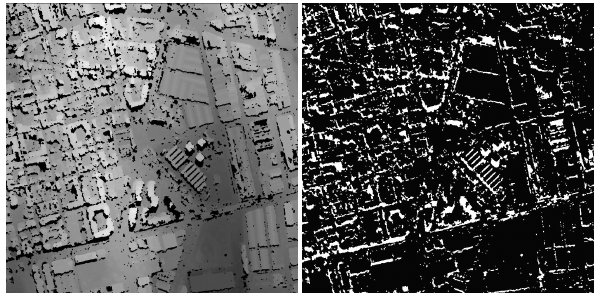
Figure 14: Detail of Terrassa testsite 1 km × 1 km, left DSM with small holes filled, right occlusion mask